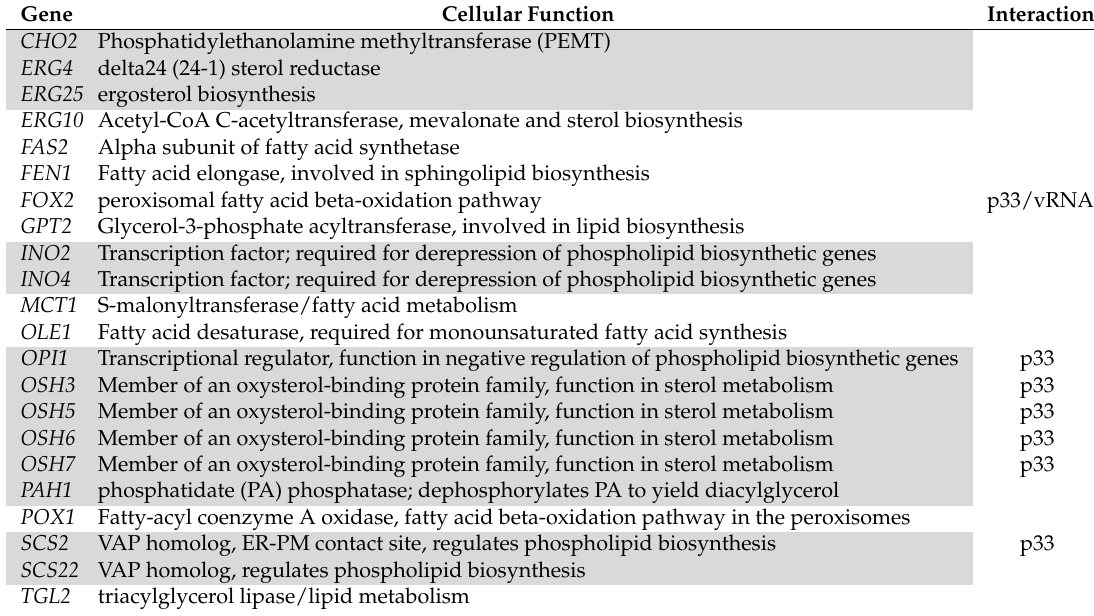
Table 1. Identified lipid metabolism or lipid transport proteins involved in TBSV